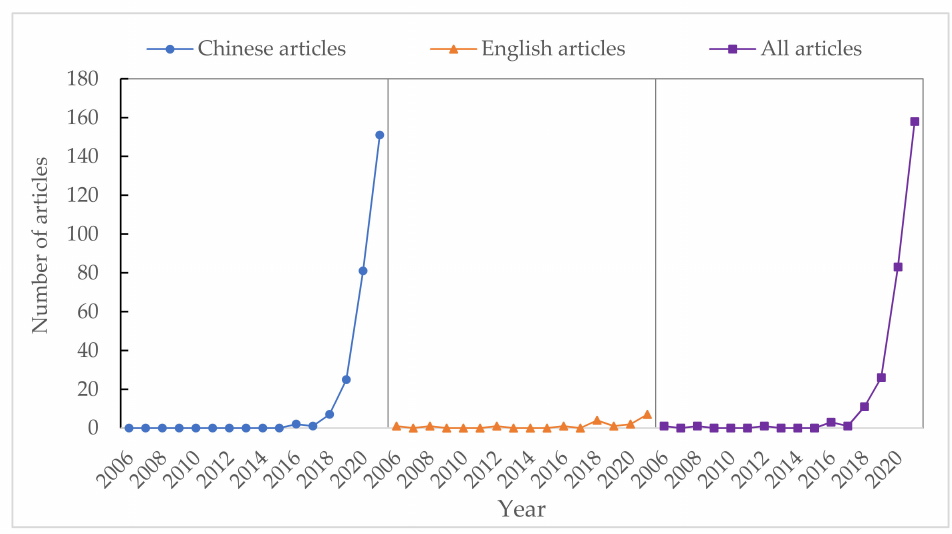
Figure 3. Annual distribution of